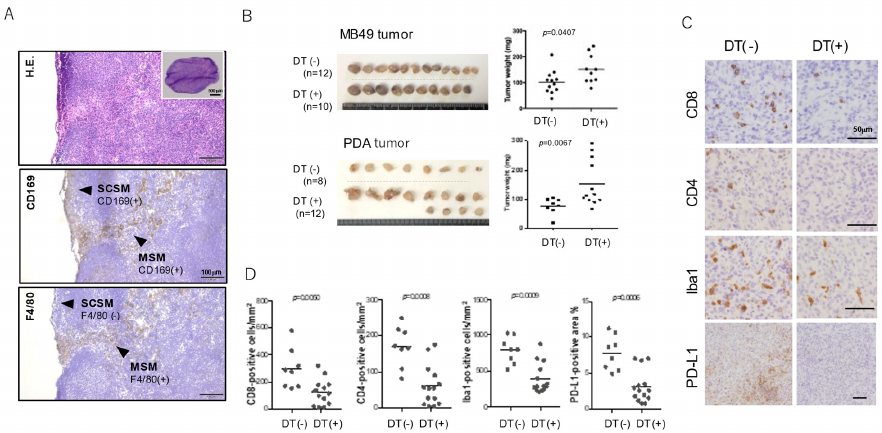
Figure 1. In vivo murine tumor model in CD169-DTR mice. ( A ) Representative figure of hematoxylin and eosin staining and immunohistochemical staining of CD169 (brown colored) of murine lymph nodes. ( B ) Following subcutaneous injection of diphtheria toxin (DT) on day 0, mice were inoculated subcutaneously with 5 × 10 5 tumor cells (day 1). Subcutaneous tumor nodules were dissected after 10 days (day 11). ( C ) Tumor samples were fixed and embedded in paraffin. Sections were stained with anti-CD8, anti-CD4, anti-Iba1 (marker for pan-macrophage), and anti–PD-L1 antibodies. ( D ) Cell count and signal value data were evaluated using ImageJ software. Differences between the two groups were evaluated using the Mann–Whitney U